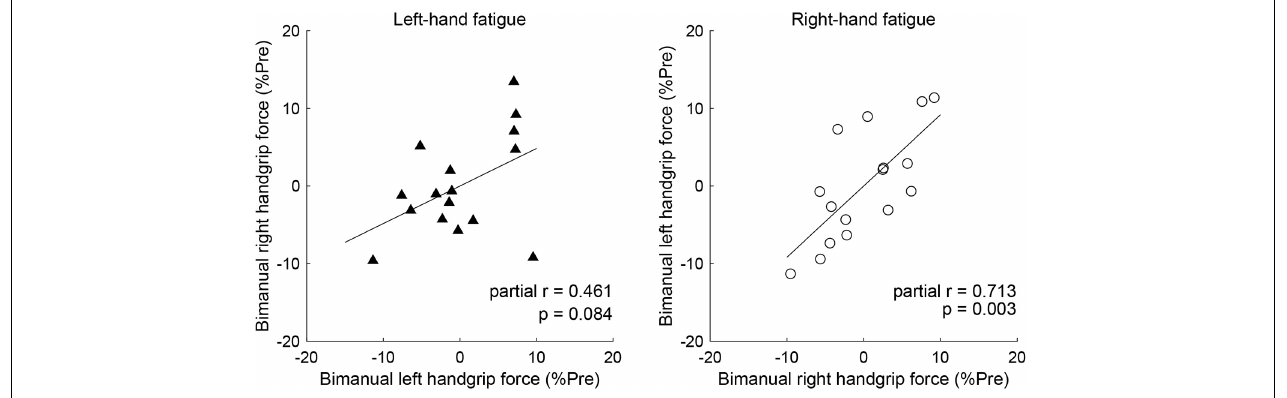
FIGURE 5 | Partial correlation of the left- and right-hand in bimanual handgrip force controlling for unimanual handgrip force. Partial correlation coefficients were used to determine the relationship between post-test bimanual left (BL) and right (BR) handgrip force normalized by the pre-test by controlling for unimanual left (UL) or right (UR) handgrip force in the left-hand and right-hand fatigue conditions, respectively. Data are plotted as residuals of each variable adjusted by control variable. The linear line indicates least squares regression.